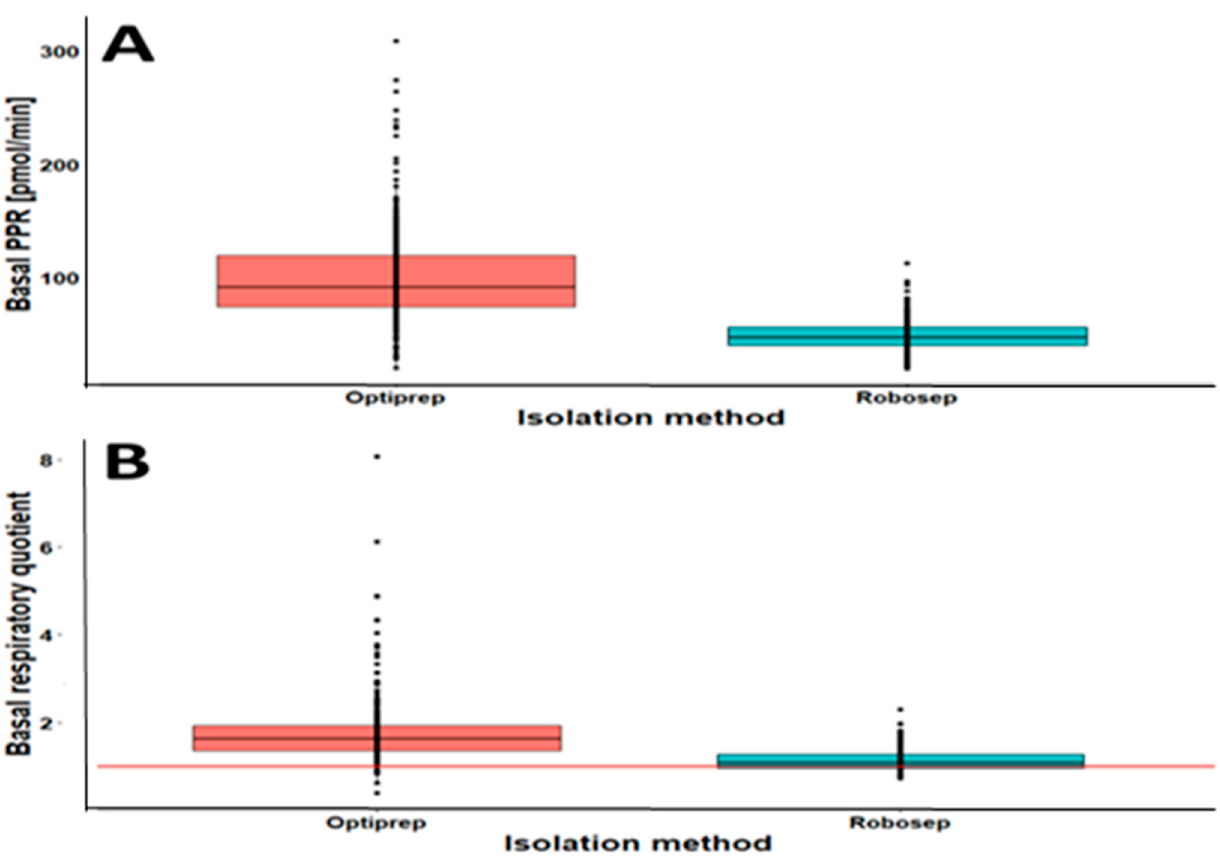
Figure 3. Boxplots of the basal proton production rate (PPR) ( A ) and the basal respiratory quotient (RQ) ( B ) of PBMCs isolated by OptiPrep ® ( n = 293) density centrifugation or Robosep TM -S negative selection ( n = 185). The red line in B indicates an RQ of 1.0, which is related to the complete oxidation of glucose by the cells. The outliers (black dots) in ( A , B ) are defined as data points for PPR and RQ, respectively, located outside the whiskers of the boxplots. The greater the number of outliers, the more inconsistent the PPR and RQ results.